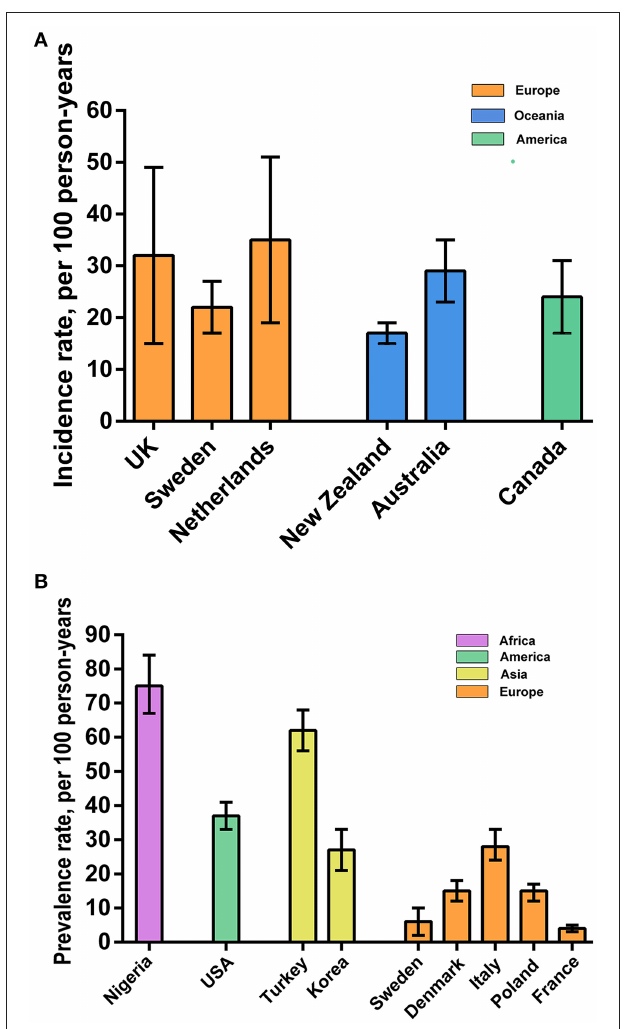
FIGURE 3 | Geographical regions. (A) Incidence of PSSP on different geographical regions; (B) Prevalence of PSSP on different geographical regions.